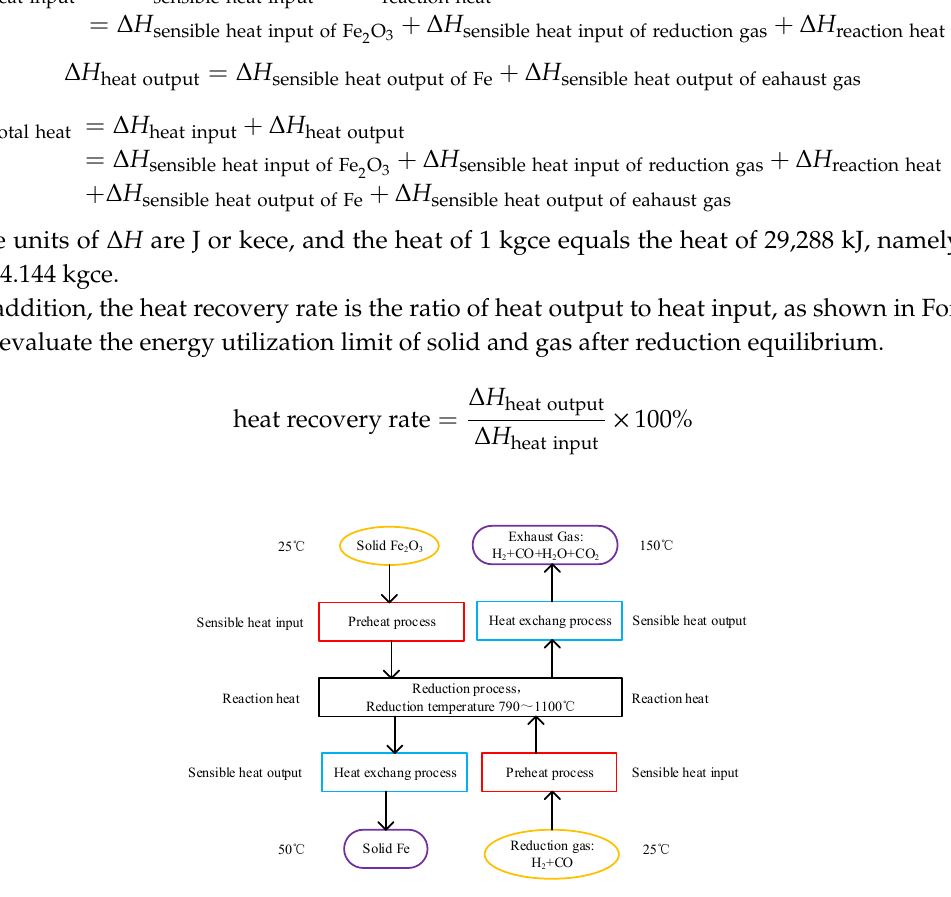
Figure 1. Schematic diagram of energy consumption model of gas-based direct reduction ironmaking process.